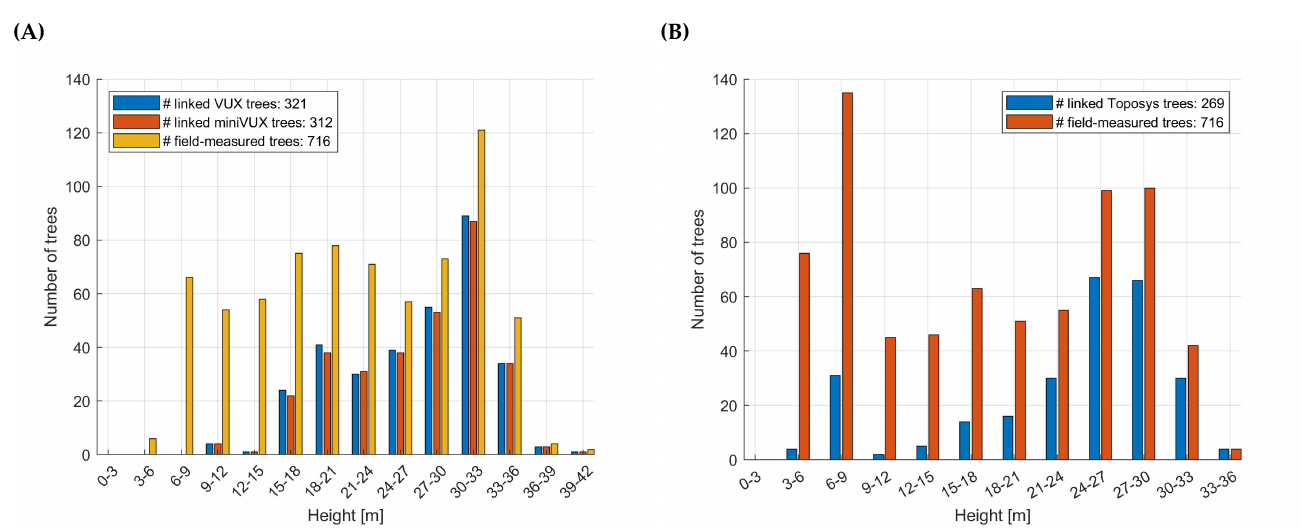
Figure 3. ( A ): The number of found and linked ALS-derived trees from 2021 compared to the field- measured trees of 2021. The x axis describes the height of the tree in 2021 and is divided into 3 m intervals. ( B ): The same distribution for 2000 ALS-derived trees with respective field-measured trees, with the x axis representing the height in 2000. Table 5. The results of linking processes for direct and indirect growth determination. Toposys VUX